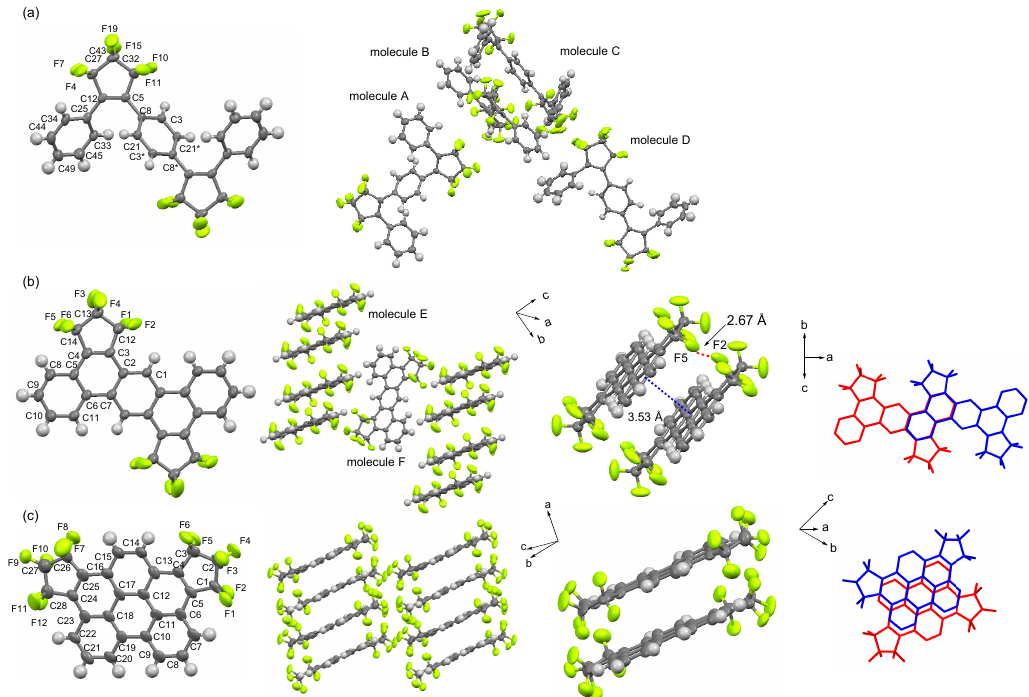
Figure 1. Molecular structures and packing modes of ( a ) 3 , ( b ) 4a , and ( c ) 4b . One of the independent molecules ( 3 : molecule A, 4a : molecule E) is shown for clarity. Two fluorine atoms (F9 and F10) bound to CF 2 carbon (C27) in 4b and some fluorine atoms in two independent molecules (molecules C and D) of 3 are disordered (see Figures S13 and S15). For 4a , the face-to-face distance is calculated between the polyaromatic hydrocarbon (PAH) cores, which are optimized by the least square method. For 4b , its crystallographic data are not satisfied to discuss the bond lengths and short-contacts distances (see Section 3.5).